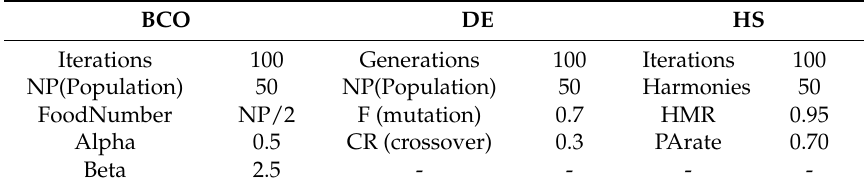
Table 4. Parameters used with the original methods.